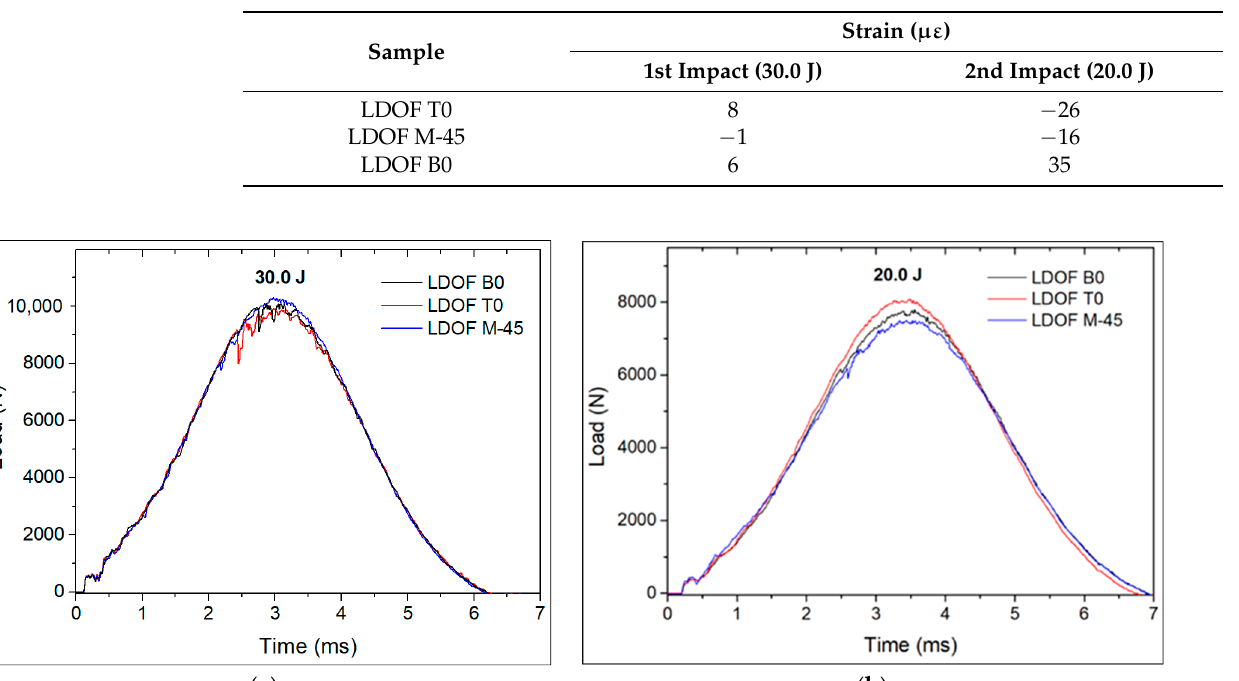
Table 2. Residual strains measured by embedded LDOF in each of the studied through-thickness locations after the first and second impacts.